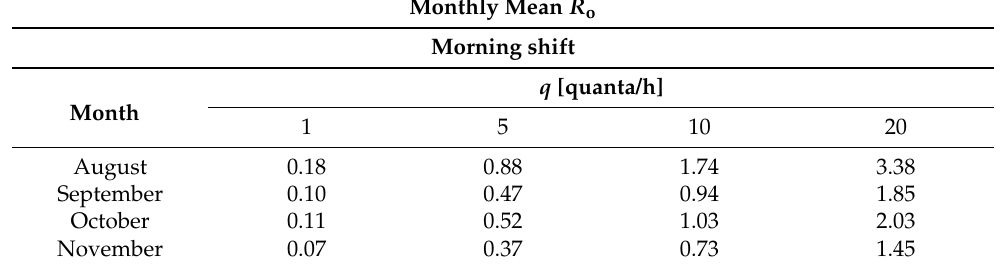
Monthly Mean R o q